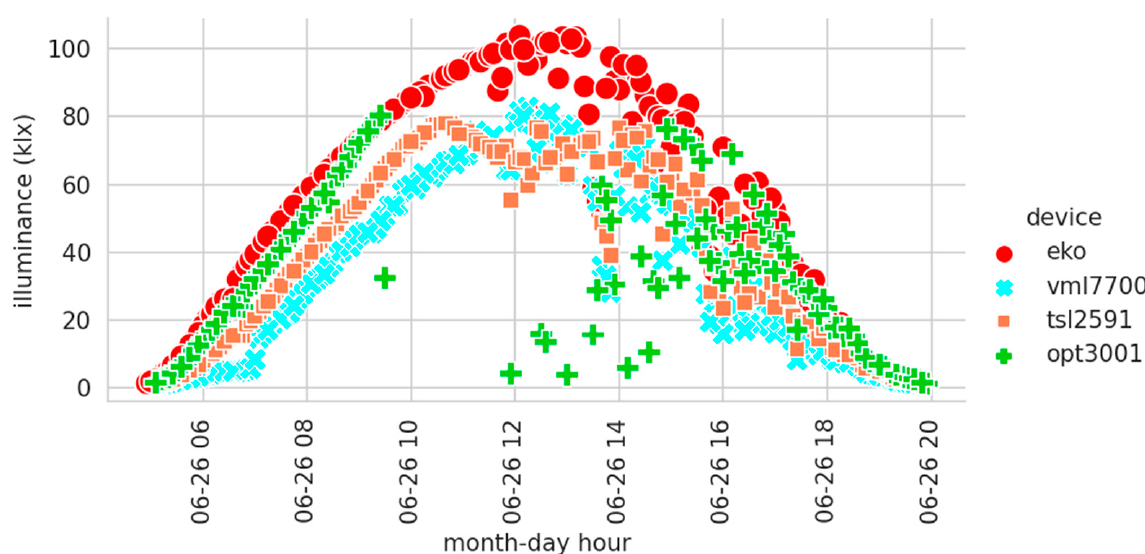
Figure 9. Illuminance measurements for 26 June 2022.